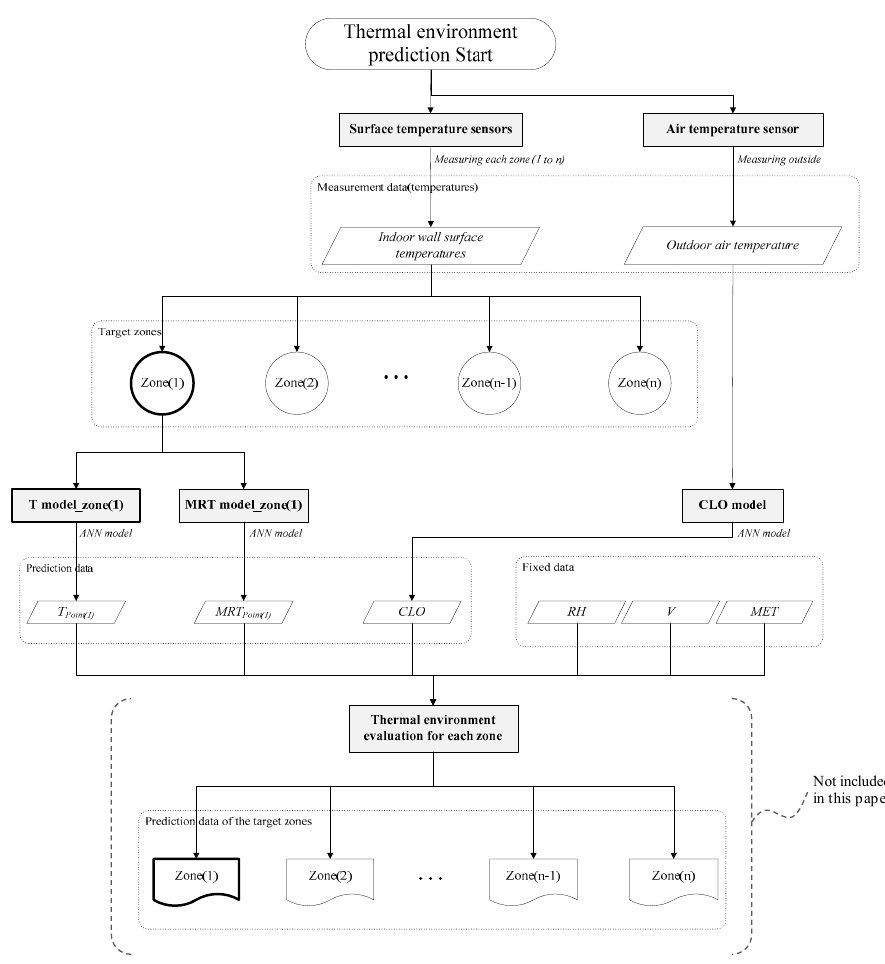
Figure 6. Thermal environment prediction process in a large space.